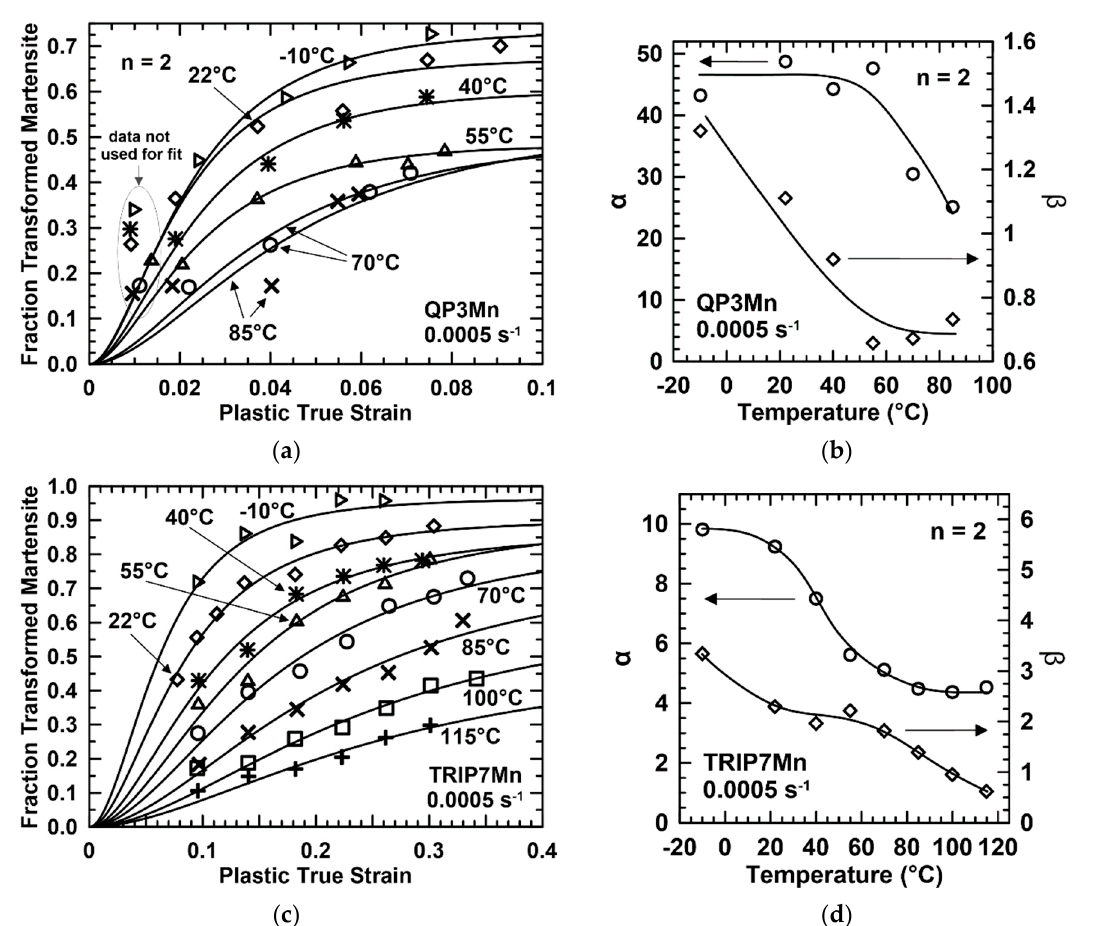
Figure 5. Fraction of transformed martensite versus plastic strain at various test temperatures (0.0005 s − 1 strain rate) for ( a ) QP3Mn and ( c ) TRIP7Mn. The points are experimental data, and the curves are the Olson–Cohen model fits. For QP3Mn, data at 2% and greater strain were used for model fits. Olson–Cohen model parameters α and β versus temperature with n equal to 2 for ( b ) QP3Mn and ( d ) TRIP7Mn.